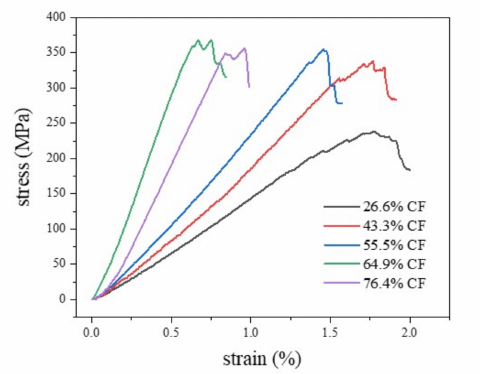
Figure 6. Stress–strain diagram of three-point flexural